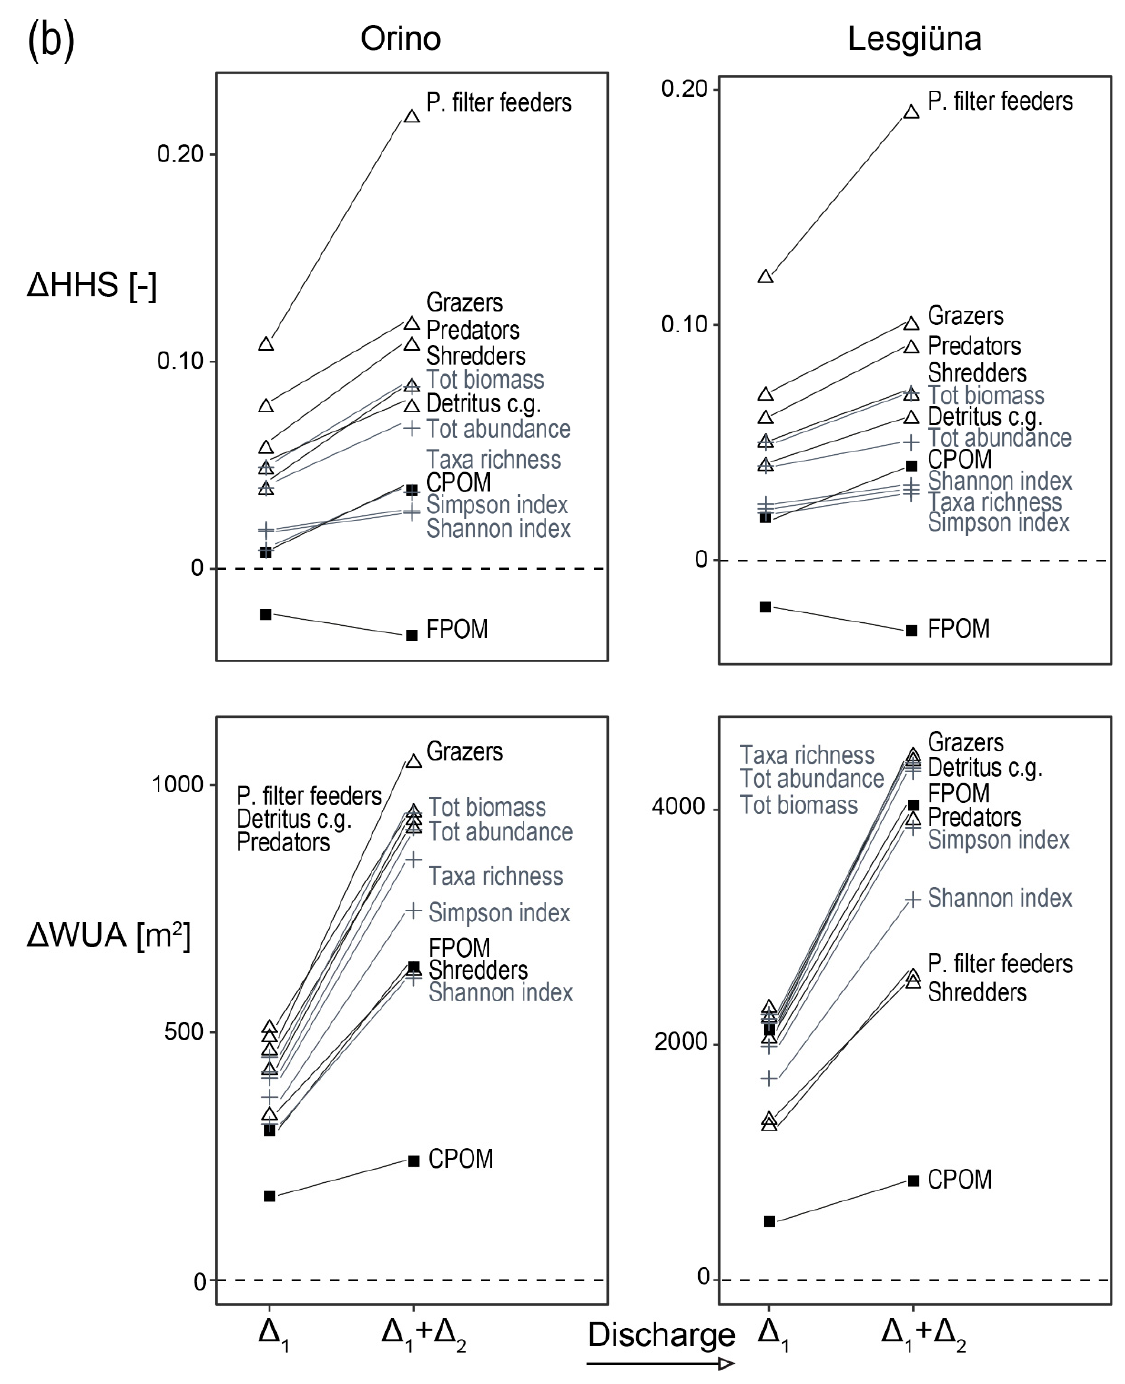
Figure 3. Changes in HHS and WUA with increasing discharge from low- to mid-flow ( ∆ 1 ) and low to high flow ( ∆ 1 + ∆ 2 ), respectively. ( Panel a ): taxa; ( Panel b ): FFGs ( ∆ ), community metrics (+, in grey), and organic resources ( (cid:4) ). ∆ 1 > 0 (dashed line) indicates that an increase in discharge from low to mid has positive effects on HHS or WUA, ∆ 1 < 0 indicates a negative effect of the discharge increase. The slope of the line connecting ∆ 1 with ∆ 1 + ∆ 2 reveals whether a further increase in discharge has positive, neutral, or negative effects on HHS or WUA compared to ∆ 1 alone. Positive slopes mean that further increase in discharge from mid- to high-flows further increased HHS or WUA. Negative slopes mean that the further discharge increase reduced the positive effects of ∆ 1 (if ∆ 1 > 0; e.g., B. rhodani and A. muticus ) or intensified the negative effects of ∆ 1 (if ∆ 1 < 0; e.g., Ecdyonurus sp. and Tanypodinae). Zero slopes mean that ∆ 2 does not affect HHS or WUA.Y-axis not in scale among